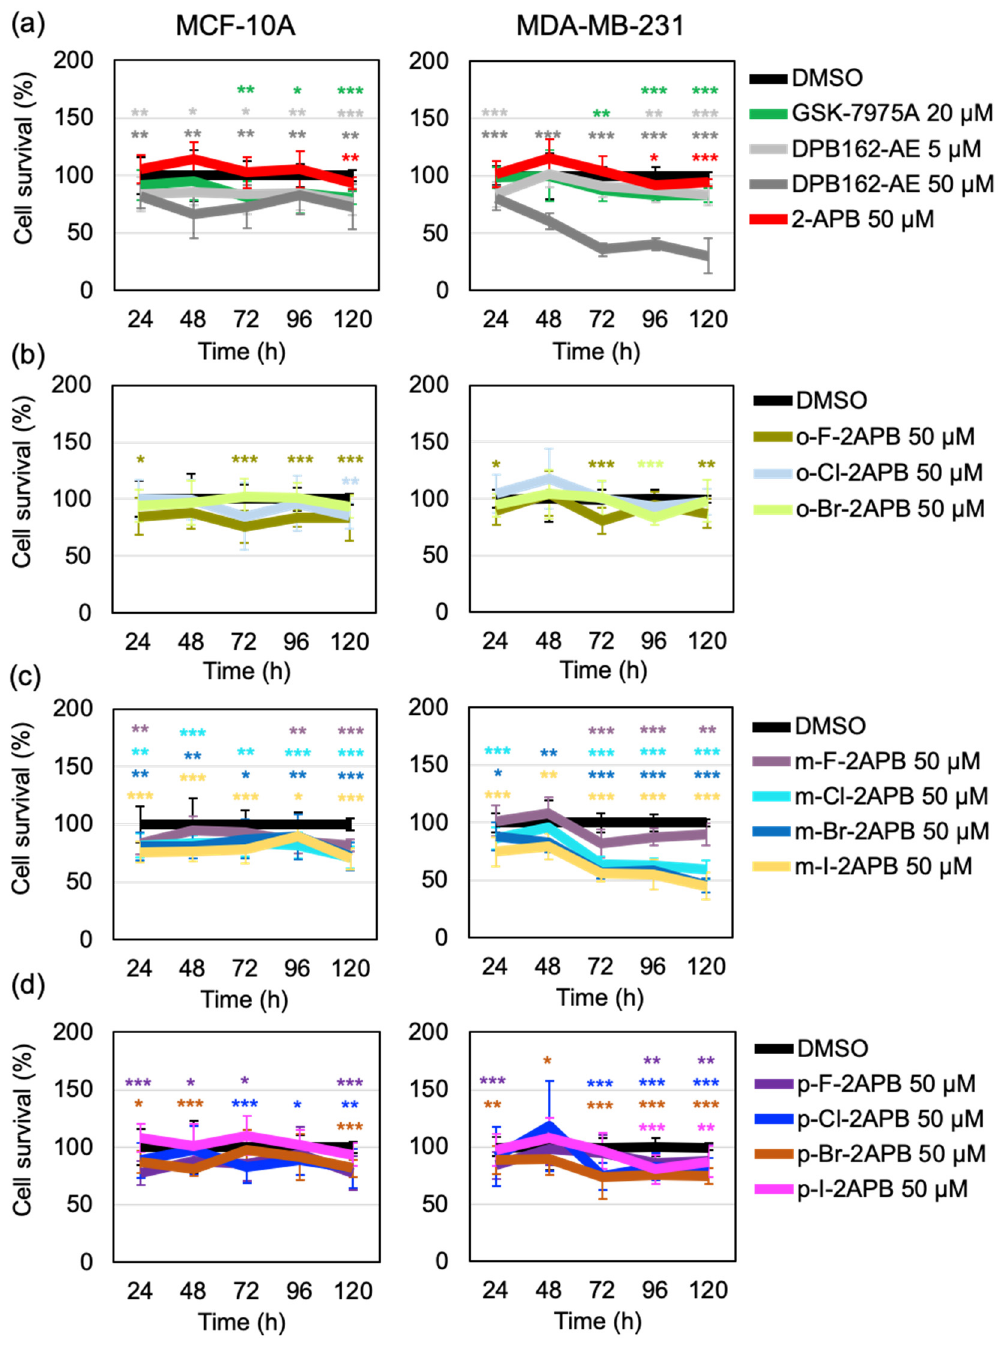
Figure 6. Dose-response curves of 20 µ M GSK-7975A , 5 µ M and 50 µ M DPB162-AE , and 50 µ M 2-APB ( a ), 50 µ M o -F-2APB , o -Cl-2APB , and o -Br-2APB ( b ) 50 µ M m -F-2APB , m -Cl-2APB , m -Br-2APB , and m -I-2APB ( c ), and 50 µ M p -F-2APB , p -Cl-2APB , p -Br-2APB , and p -I-2APB ( d ) in non-tumorigenic breast epithelial cell line MCF-10A and triple negative breast cancer cell line MDA-MB-231. Relative cell survival in case of each compound treatment was calculated as a percentage of DMSO control. Data shown are mean ± SD ( n = 12 / compound for each time point) of two independent experiments. Significance levels compared to the DMSO control are indicated as “*” for 0.01 < p ≤ 0.05, “**” for 0.001 < p ≤ 0.01, or “***” for p ≤ 0.001 and not indicated if non-significant ( p > 0.05).